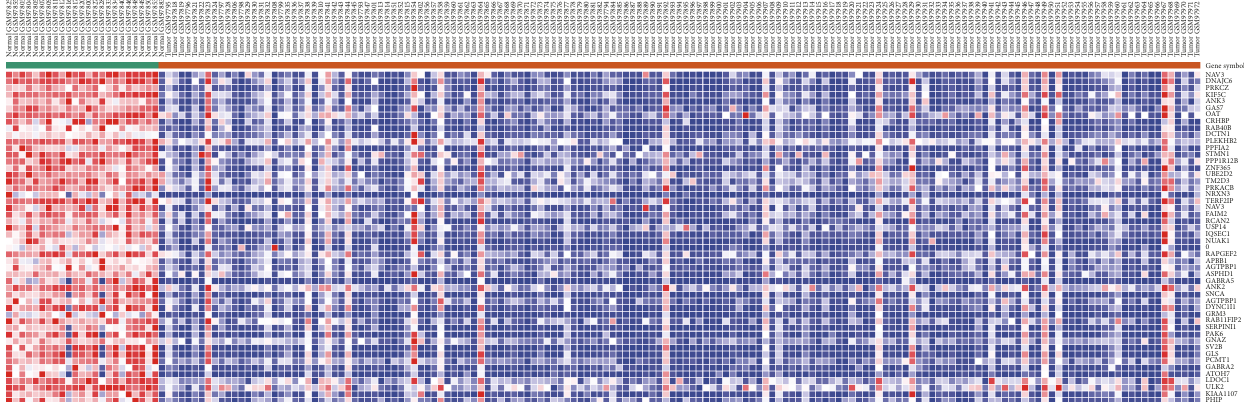
NAV3DNAJC6PRKCZKIF5CANK3GAS7OATCRHBPRAB40BDCTN1PLEKHB2PPFIA2STMN1PPP1R12BZNF365UBE2D2TM2D3PRKACBNRXN3TERF2IPNAV3FAIM2RCAN2USP14IQSEC1NUAK10RAPGEF2APBB1AGTPBP1ASPHD1GABRA5ANK2SNCAAGTPBP1DYNC1I1GRM3RAB11FIP2SERPINI1PAK6GNAZSV2BGLSPCMT1GABRA2ATOH7LDOC1ULK2KIAA1107PHIP